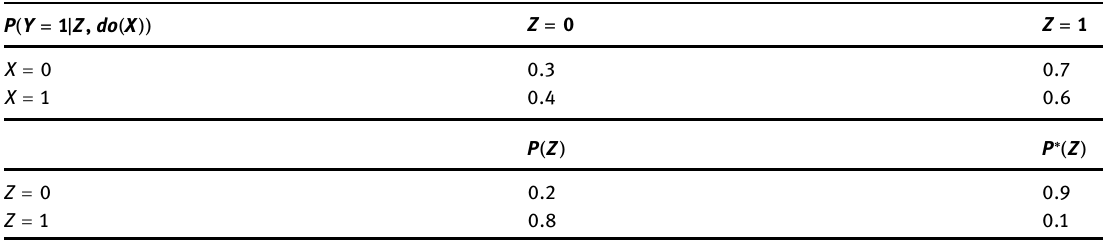
Table 3: Select distributions from environments π π , ∗ in Example 4.2 P Y Z do X 1 , ( = ∣ ( )) Z 0 = Z 1 = X 0 = 0.3 X 1